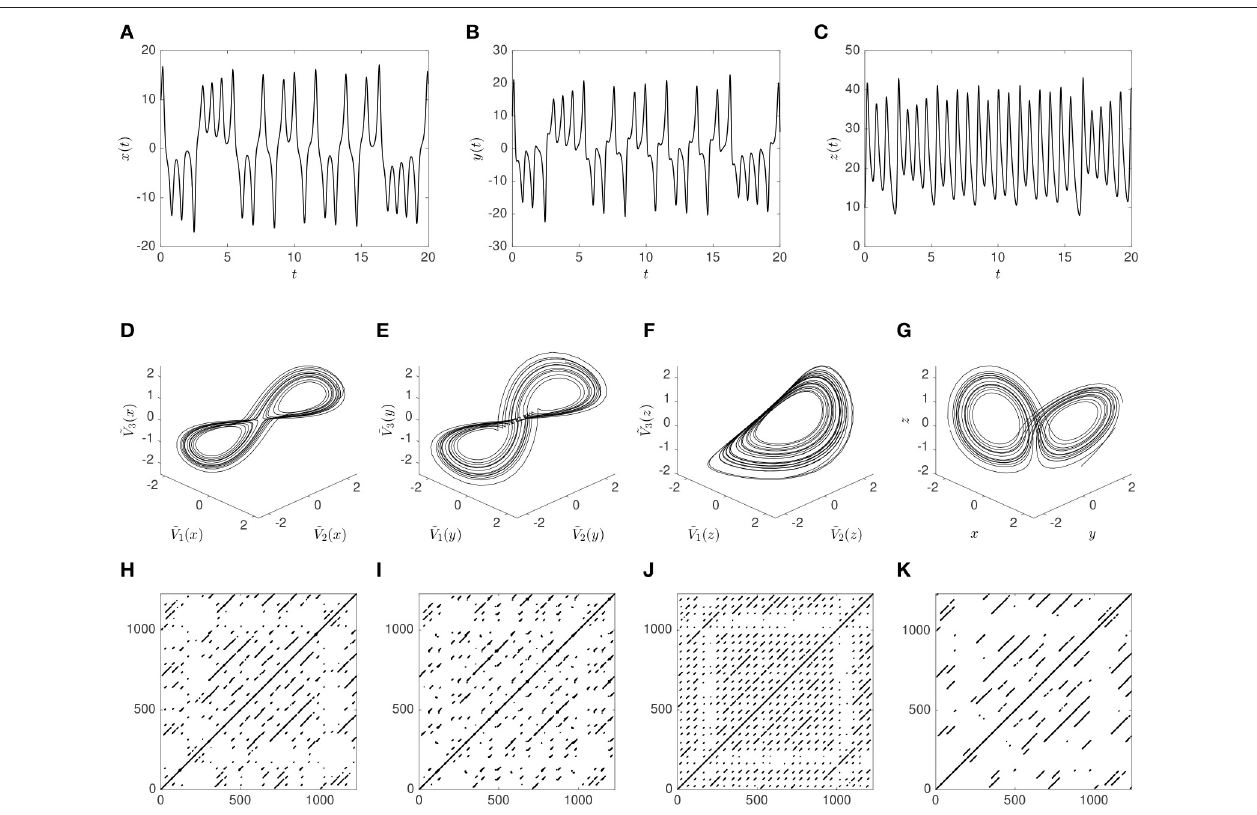
FIGURE 3 | The time series for x (A), y (B) , and z (C) obtained by numerical integration in the solution interval. The Lorenz attractor (G) is the phase space plot of x , y , and z shown in z -scored dimensions. The reconstructed attractor based on time delayed embedding of x , y , and z respectively, with D = 3 and τ = 4, is shown in (D–F) (also in z -scored dimensions). Finally recurrence plots, using a threshold T = 0.1 to define a recurrence, are shown for the reconstructed attractors, based on x (H) , y (I) , and z (J) ; as well as based on the original attractor (K) with a threshold T =